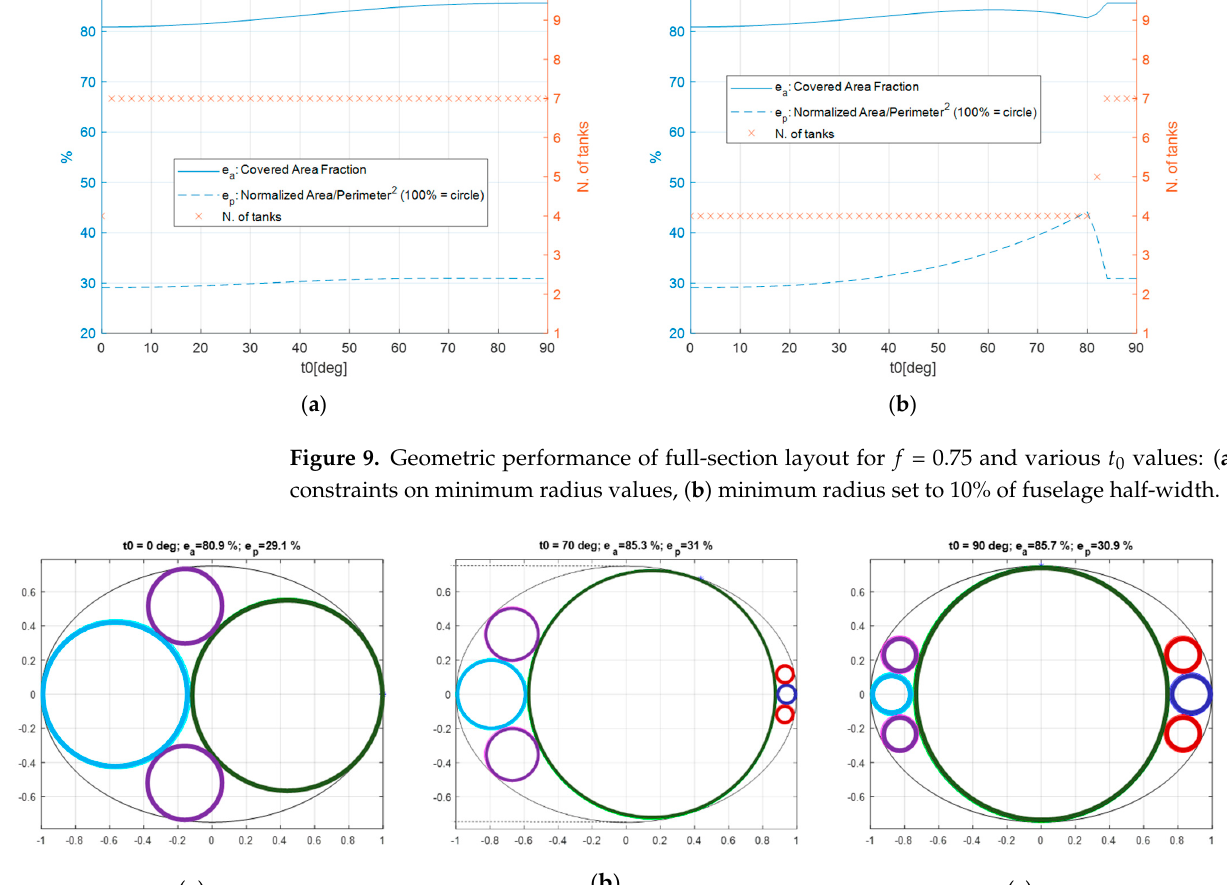
( b ) Figure 11. Part-section layouts: ( a ) available space in the upper part of the cross-section; ( b ) avail- able space in the lower part of the cross-section. Considering the trends shown in Figure 9, the main remarks concern: